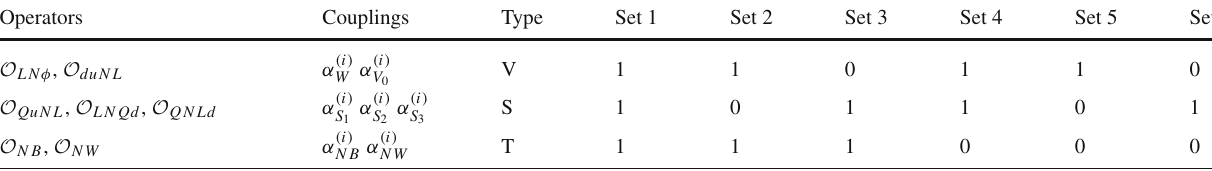
Table 2 Effective operators benchmark